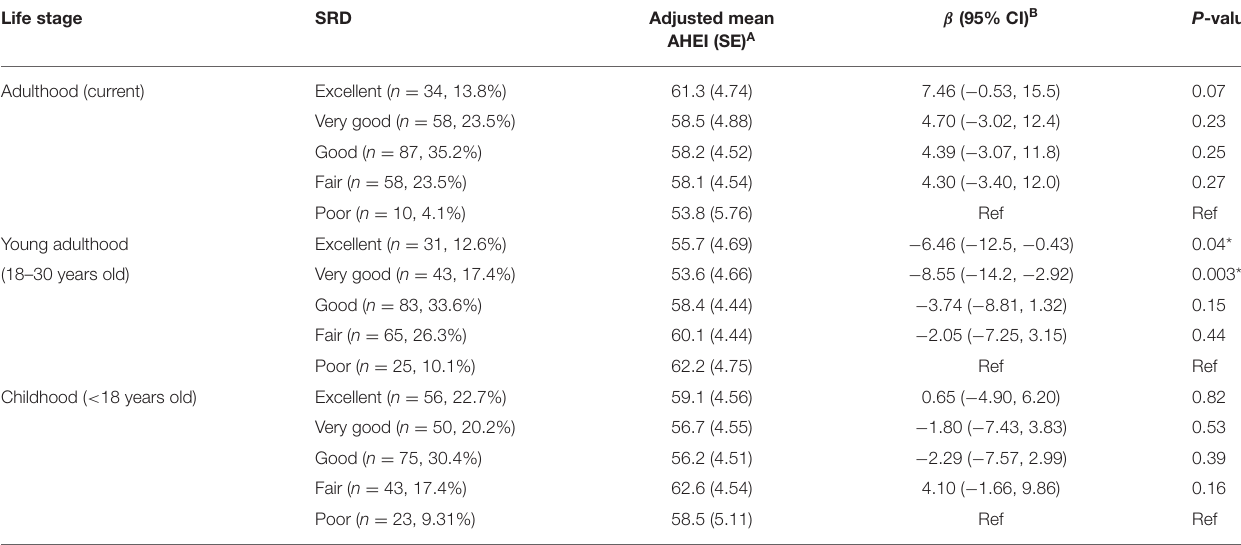
TABLE 2 | Adjusted mean Alternate Healthy Eating Index score by self-rated diet as a continuous and categorical variable at three life stages (adulthood, young adulthood, childhood) on a five-point scale ( n = 247). Life stage